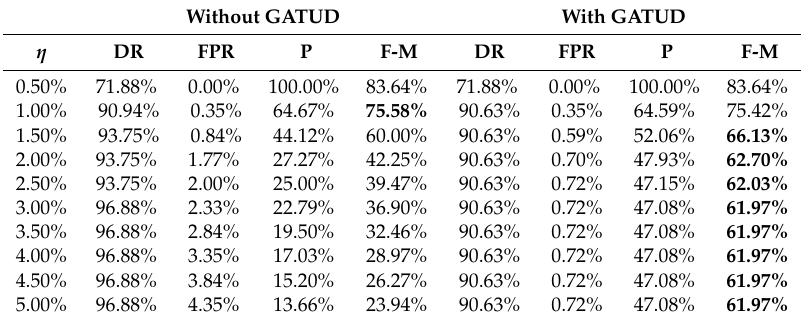
Table 6. The separation accuracy of abnormal observations with/without GATUD on SORD.